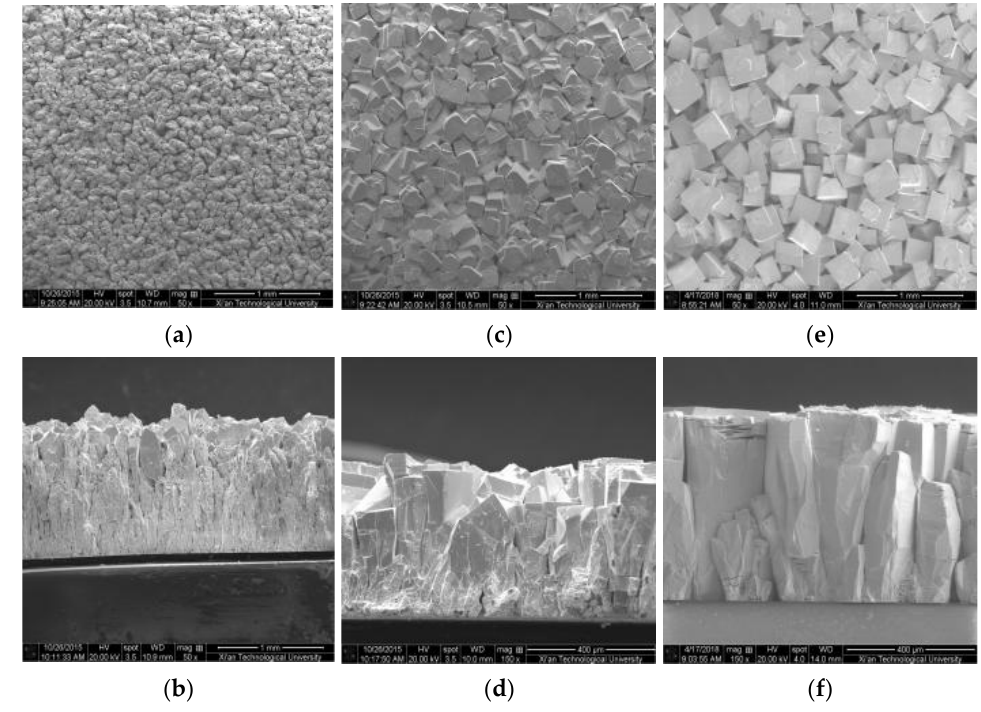
Figure 1. Top ( a,c,e ) and side ( b,d,f ) SEM views of polyscrystalline HgI 2 films. Figure 1. Top ( a , c , e ) and side ( b , d , f ) SEM views of polyscrystalline HgI